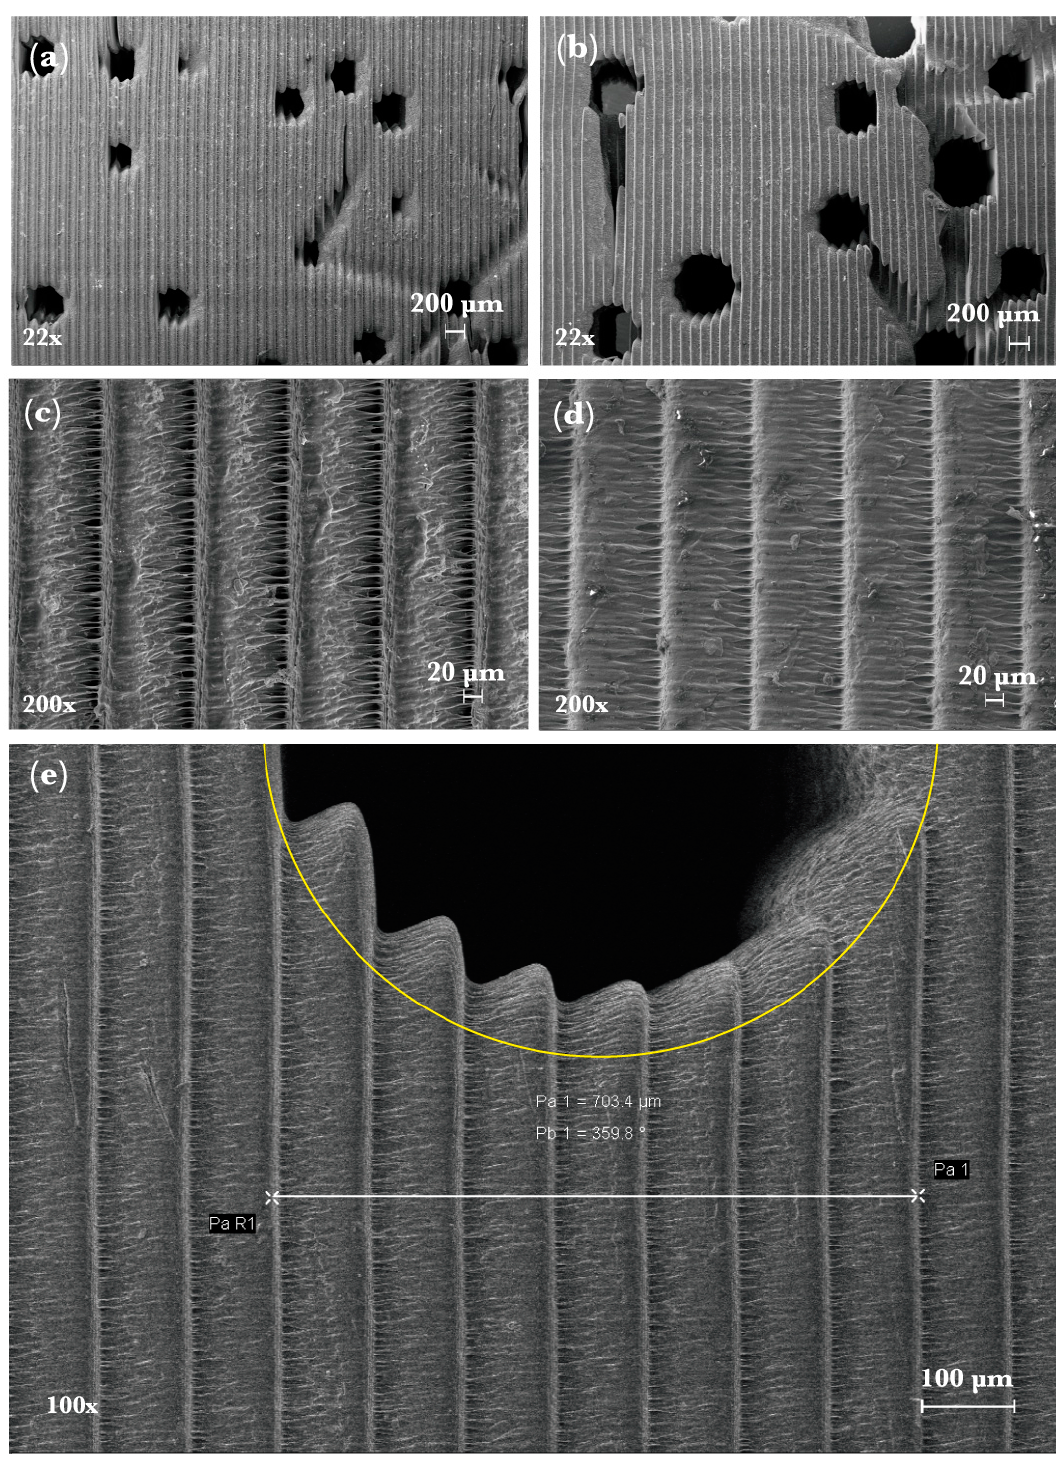
Figure 6. SEM micrographs of top lateral surfaces of Model I and Model III. ( a ) Model I, ( b ) Model III; ( c ) image of layers of a model before curing; ( d ) image of layers after curing; ( e ) designed pore in yellow and the printing result for Model III.